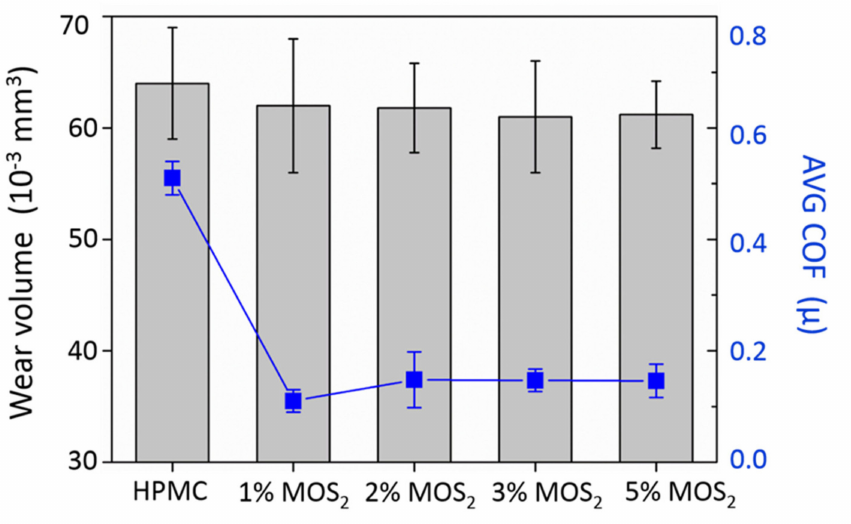
Figure 8. Wear volume and average coefficient of friction of MoS 2 /HPMC